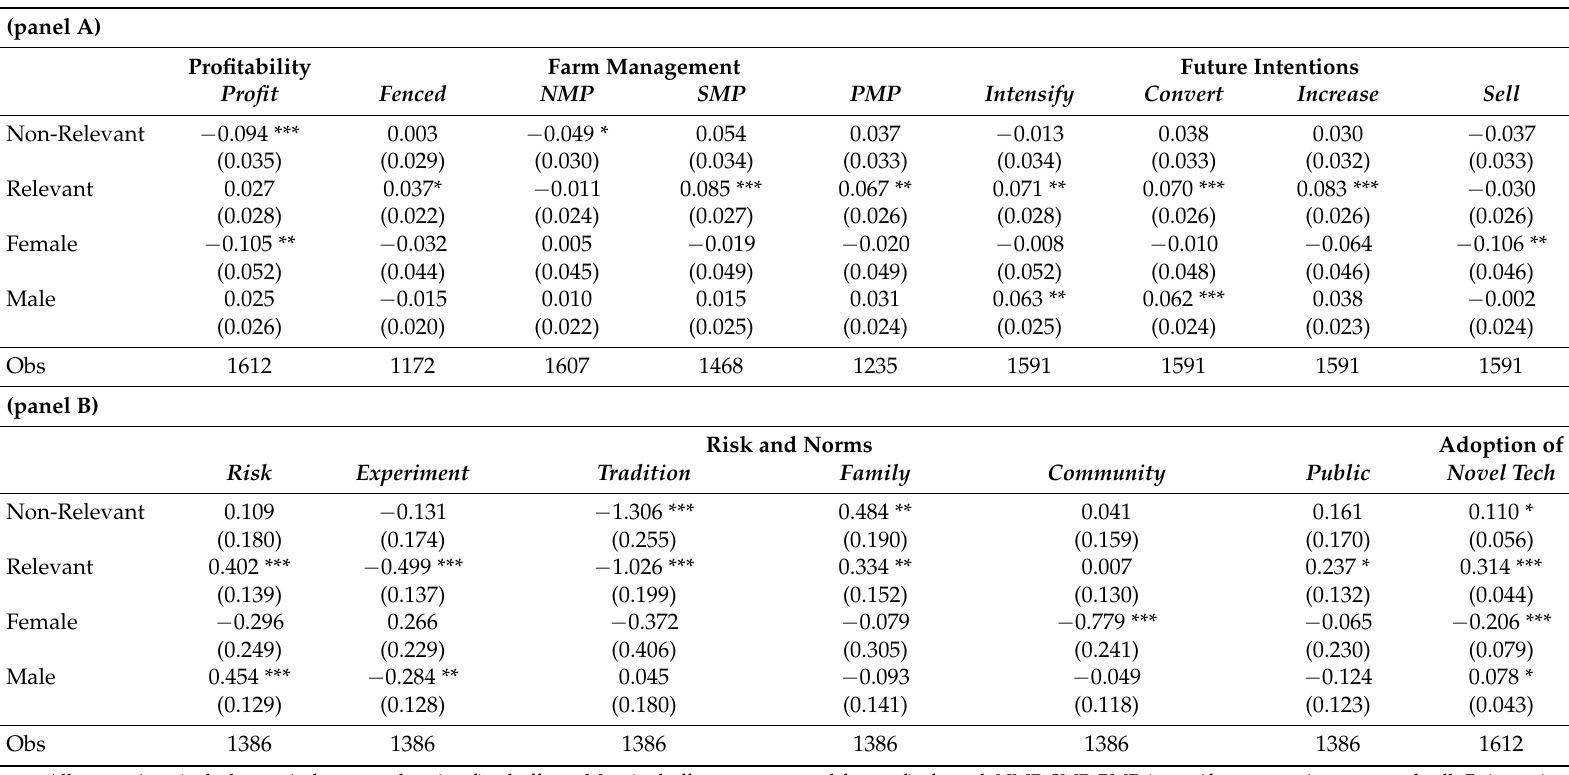
Table 4. Probit, Tobit, and Negative Binomial